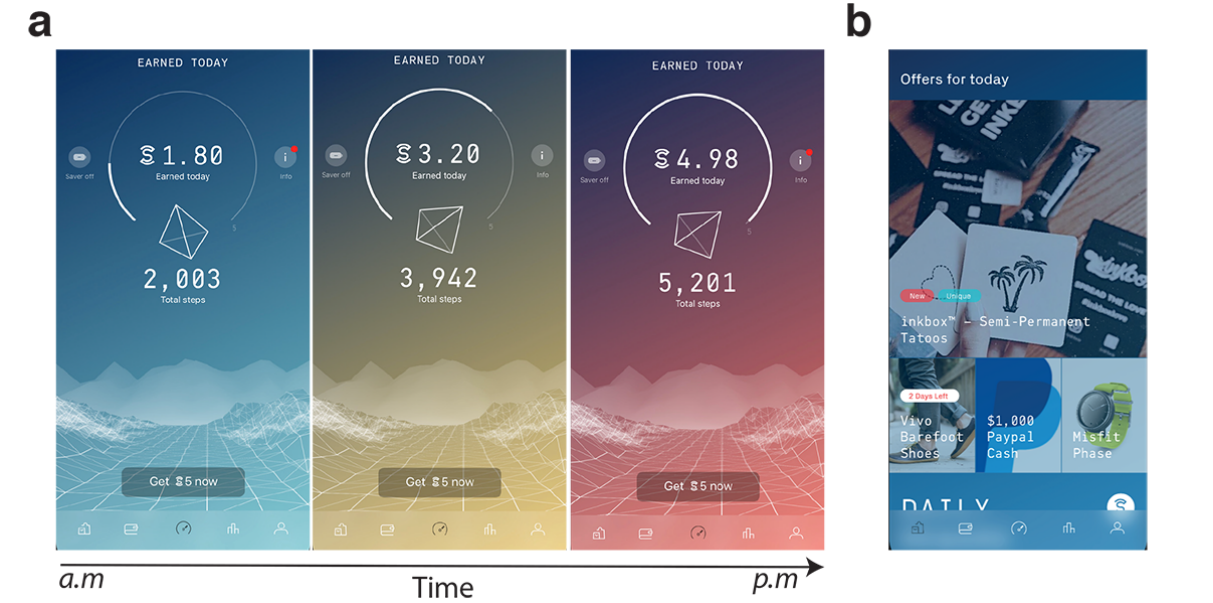
Figure 1. (a) Screenshots from the Sweatcoin app (as of December 2018). As a user’s step count (recorded by their smartphone) accumulates over the day, it is verified and converted into Sweatcoins. (b) The Sweatcoins are stored in the user’s wallet and can be subsequently used to purchase products, services, or subscriptions that are available on the